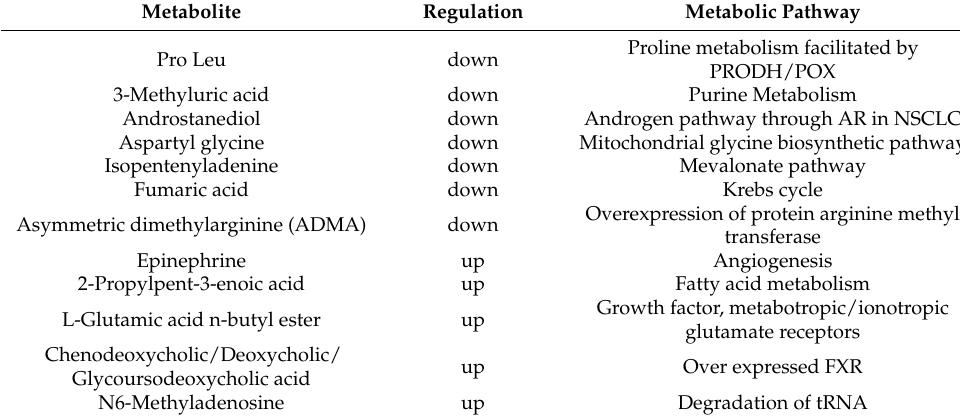
Table 6. Metabolites of significance and the associated metabolic pathways.